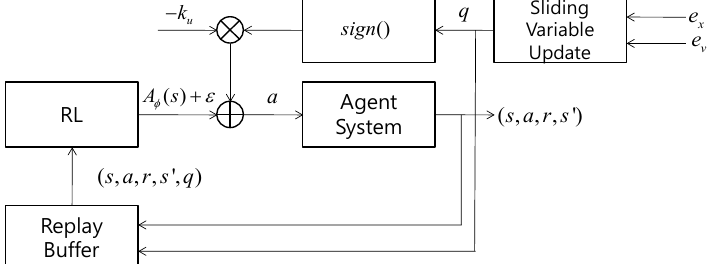
Figure 2. Structure of sliding mode RL.